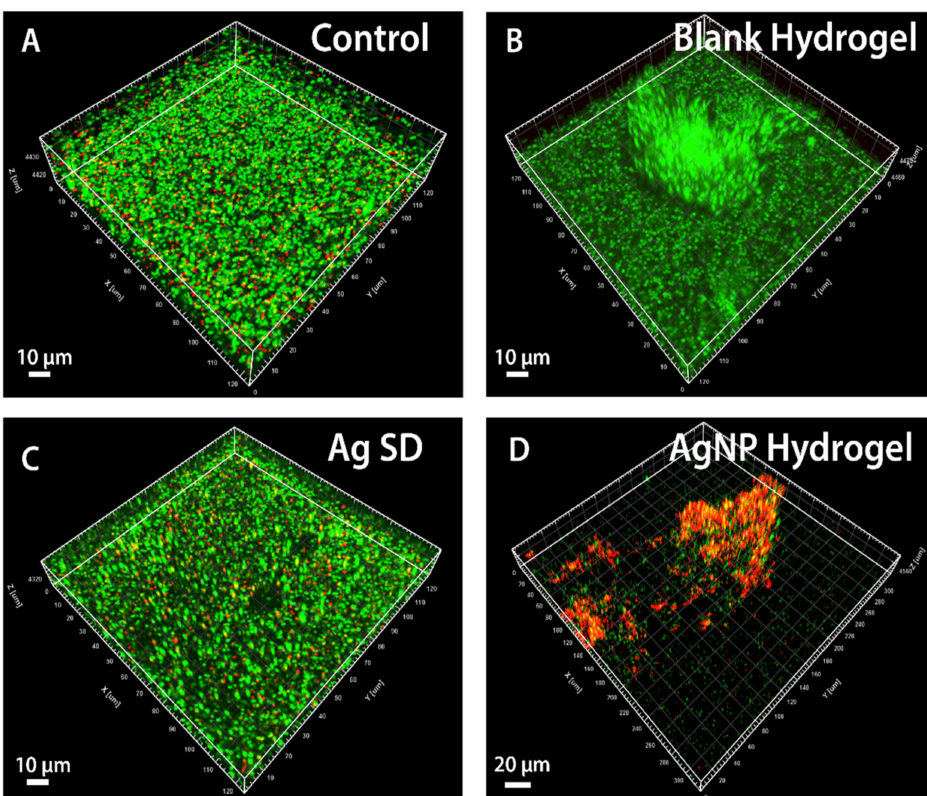
Figure 3. In vitro antibiofilm activity of the AgNP hydrogel. ( A – D ) CLSM 3D micrographs of S. aureus biofilm structure after treatment with bacterial broth, blank, Ag SD, and AgNP